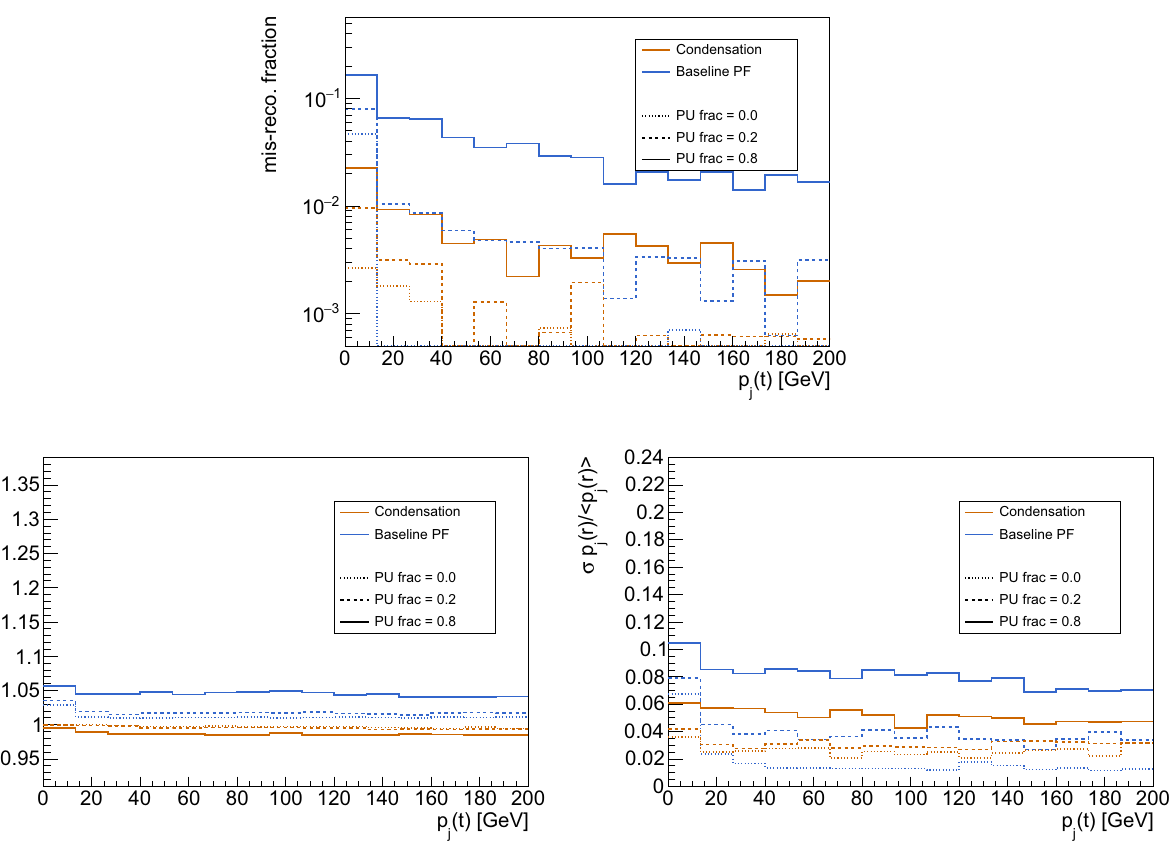
Fig. 7 Top: fraction of jets that are mis-reconstructed, defined as hav- ing a momentum response of | p j ( r ) − p j ( t ) | / p j ( t ) > 0 . 5. The bottom plots only contain jets not falling into this category. Left: mean of the jet momentum response. Right: width of the jet momentum response.